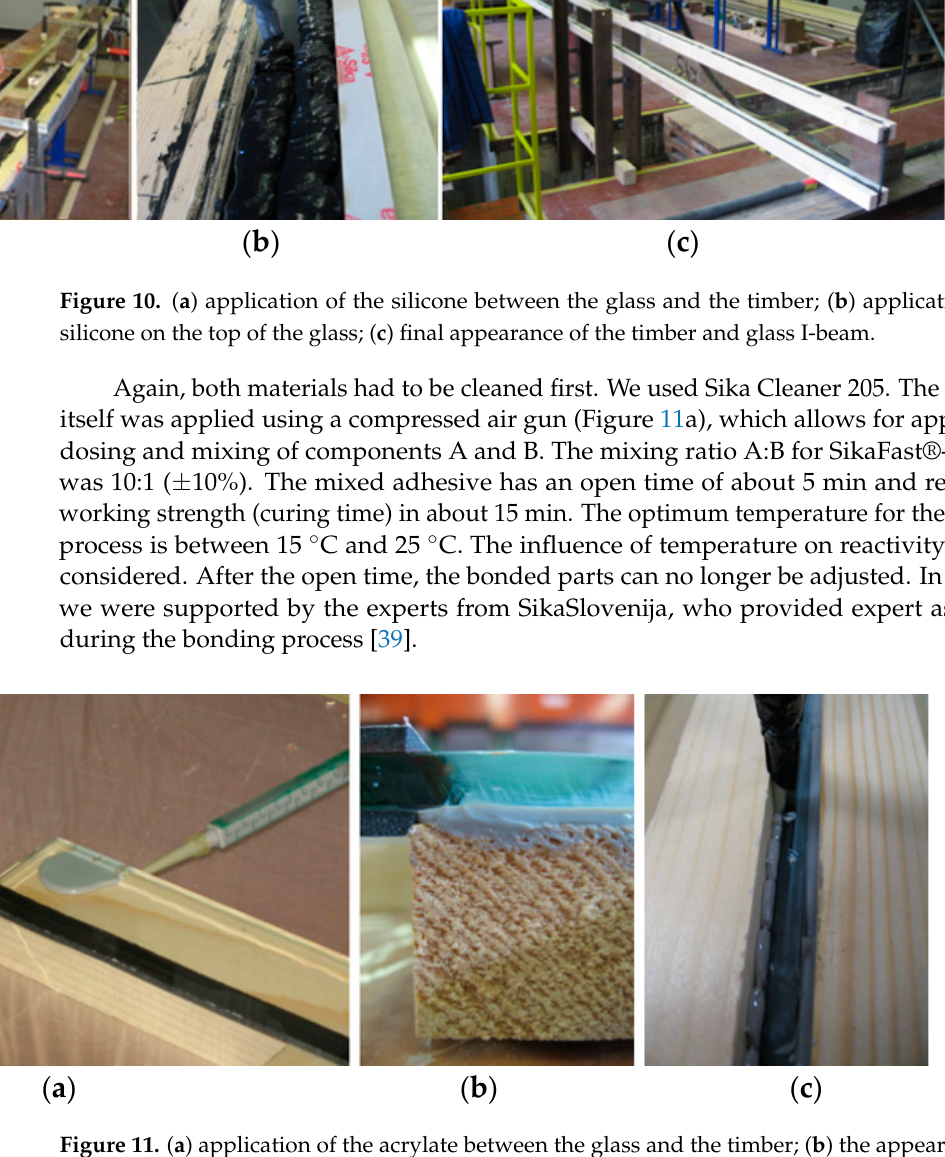
Figure 11. ( a ) application of the acrylate between the glass and the timber; ( b ) the appearance after the first bonding; ( c ) the application of the adhesive between the second flanges and the glass web.